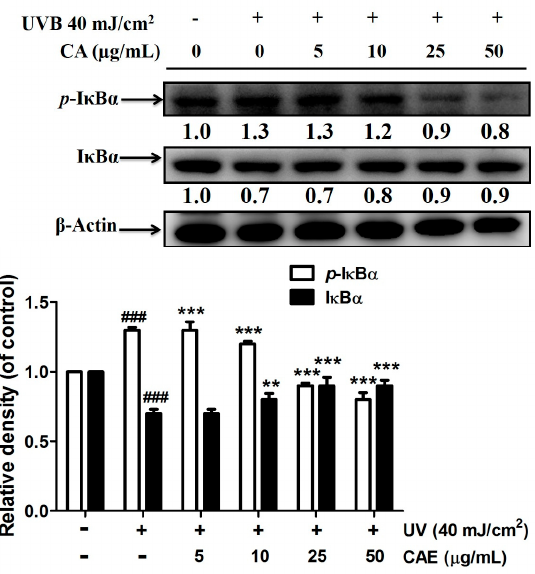
Figure 9. Effect of CAE on UVB-mediated p -I κ B α and I κ B α expression in human skin fibroblasts. Significant difference versus control: ###, p < 0.001; significant difference versus the UVB-induced group: **, p < 0.01, ***, p < 0.001.